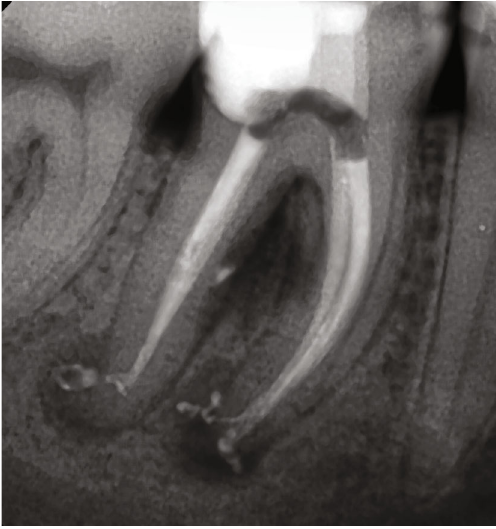
Figure 3: Apical radiograph of tooth # 46 after